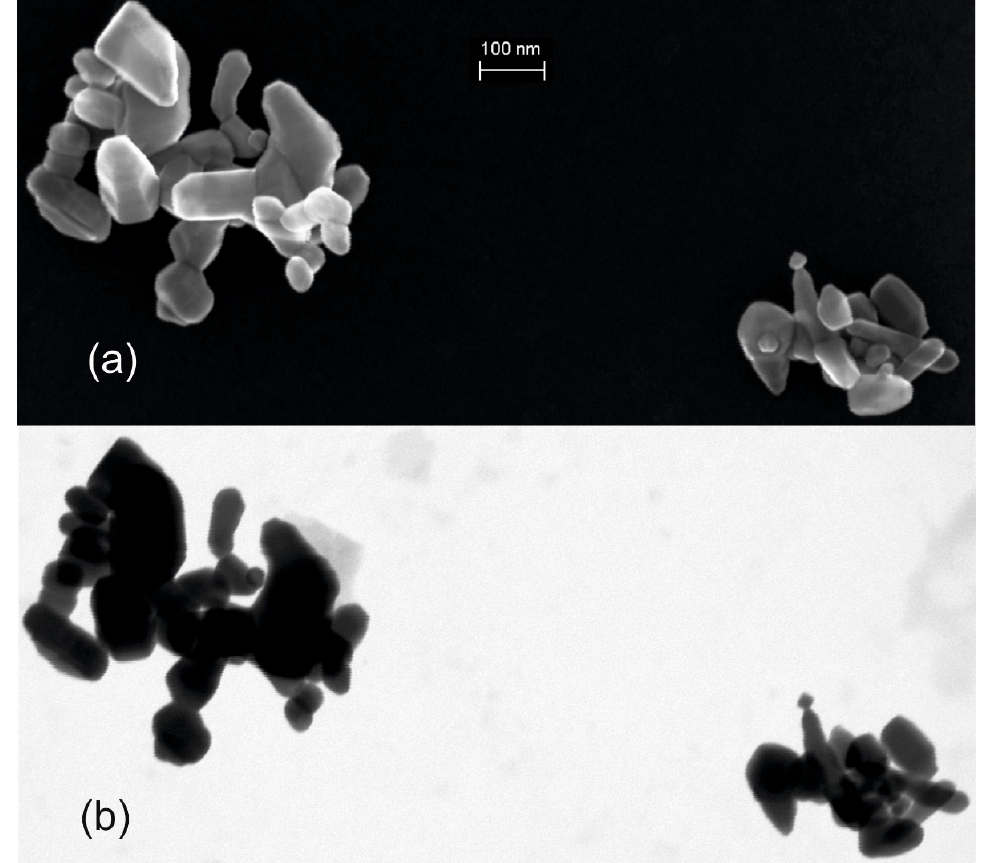
Figure 8. ( a ) SEM (SE InLens) micrograph and ( b ) STEM-in-SEM micrograph with the instrument in transmission mode of the same field-of-view as in ( a ) of two zinc oxide agglomerates/aggregates deposited on a carbon TEM grid.